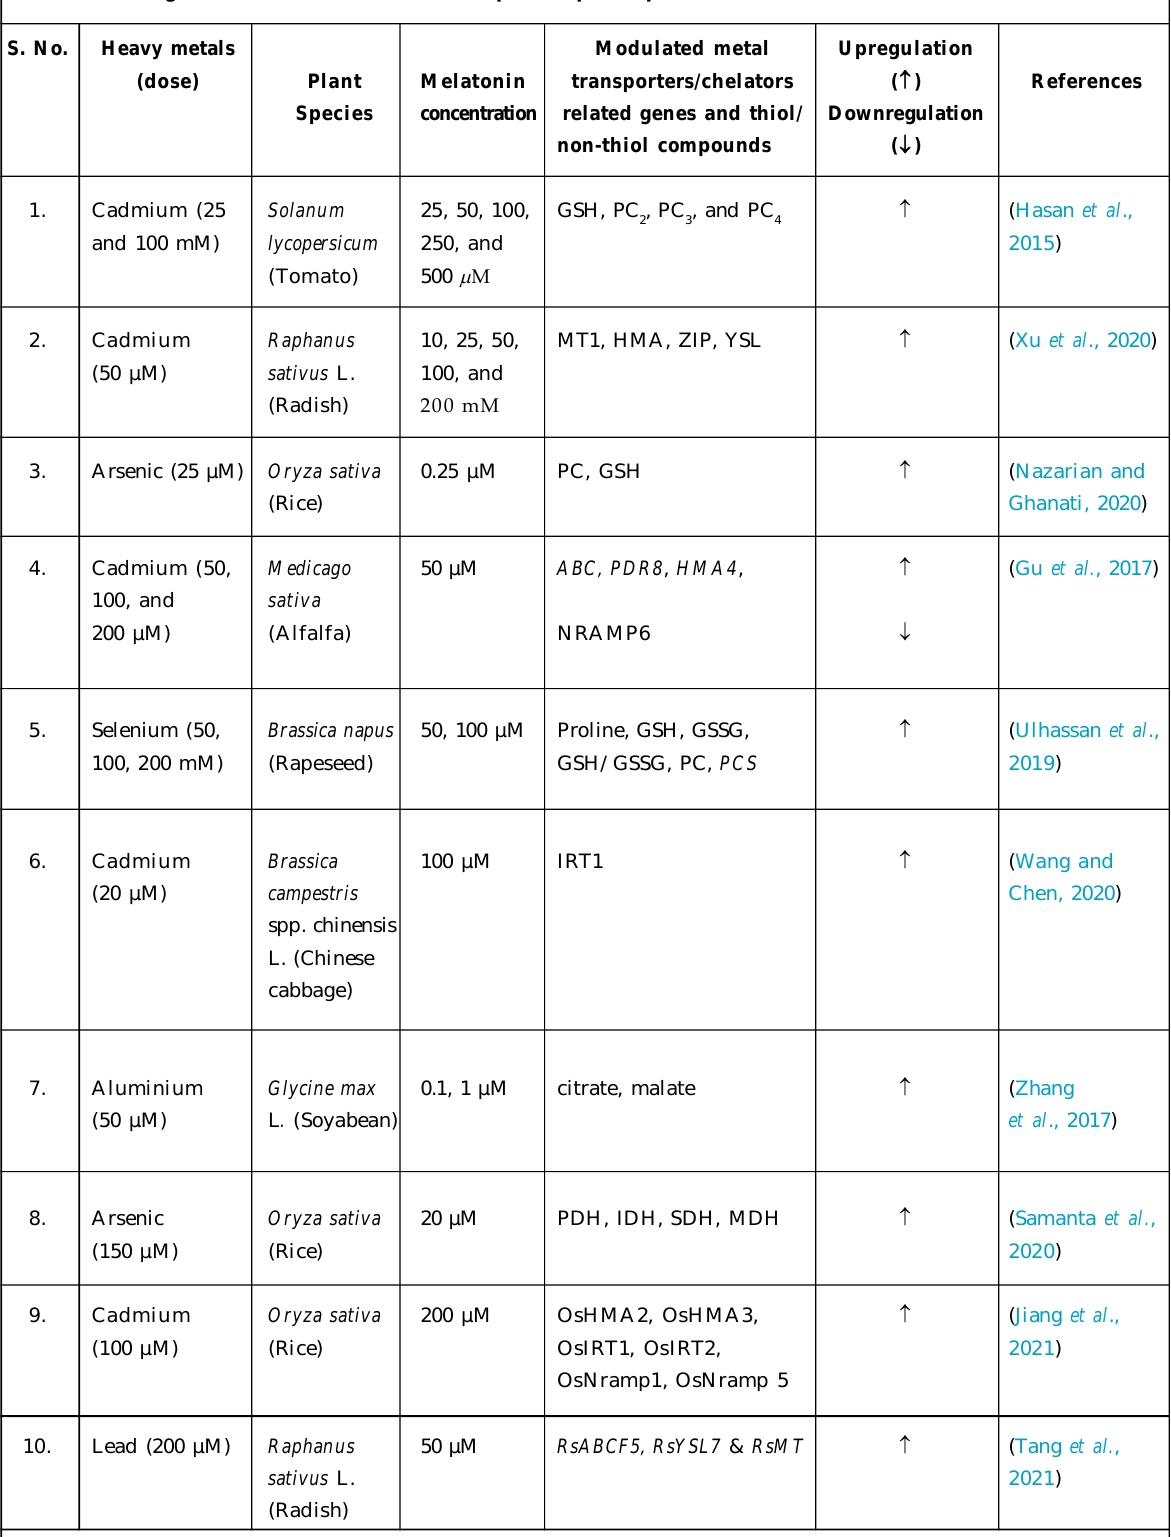
Table 1: Metal transporters/chelators and thiol/non-thiol compounds that are regulated by melatonin treatment along with their concentration in respective plant species under different HM